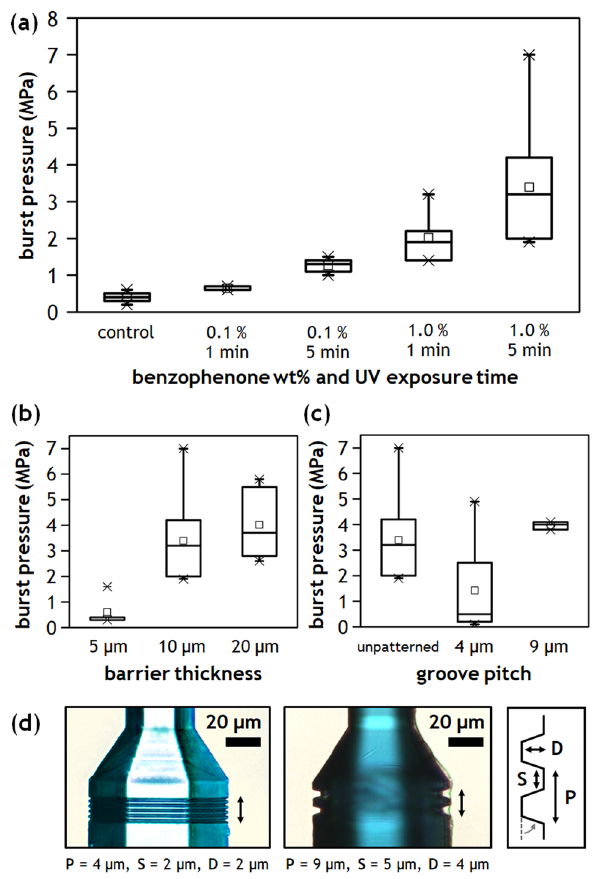
Figure 3. ( a ) Burst pressure measured across 10 µ m-thick in situ barriers printed on COP surfaces treated with varying BP concentrations and UV irradiation time. ( b ) Variation in burst pressure for different barrier thicknesses (1.0 wt% BP, 5 min UV) ( c ) Impact of surface topography on burst pressure using surfaces with trapezoidal cross section grooves (10 µ m-thick barriers, 1.0 wt% BP, 5 min UV). ( d ) Images of the grooved COP microchannels in ( c ), with selected geometries for groove pitch (P), spacing (S), and depth (D). Base angle of the ◦ trapezoidal cross section is fixed at 70